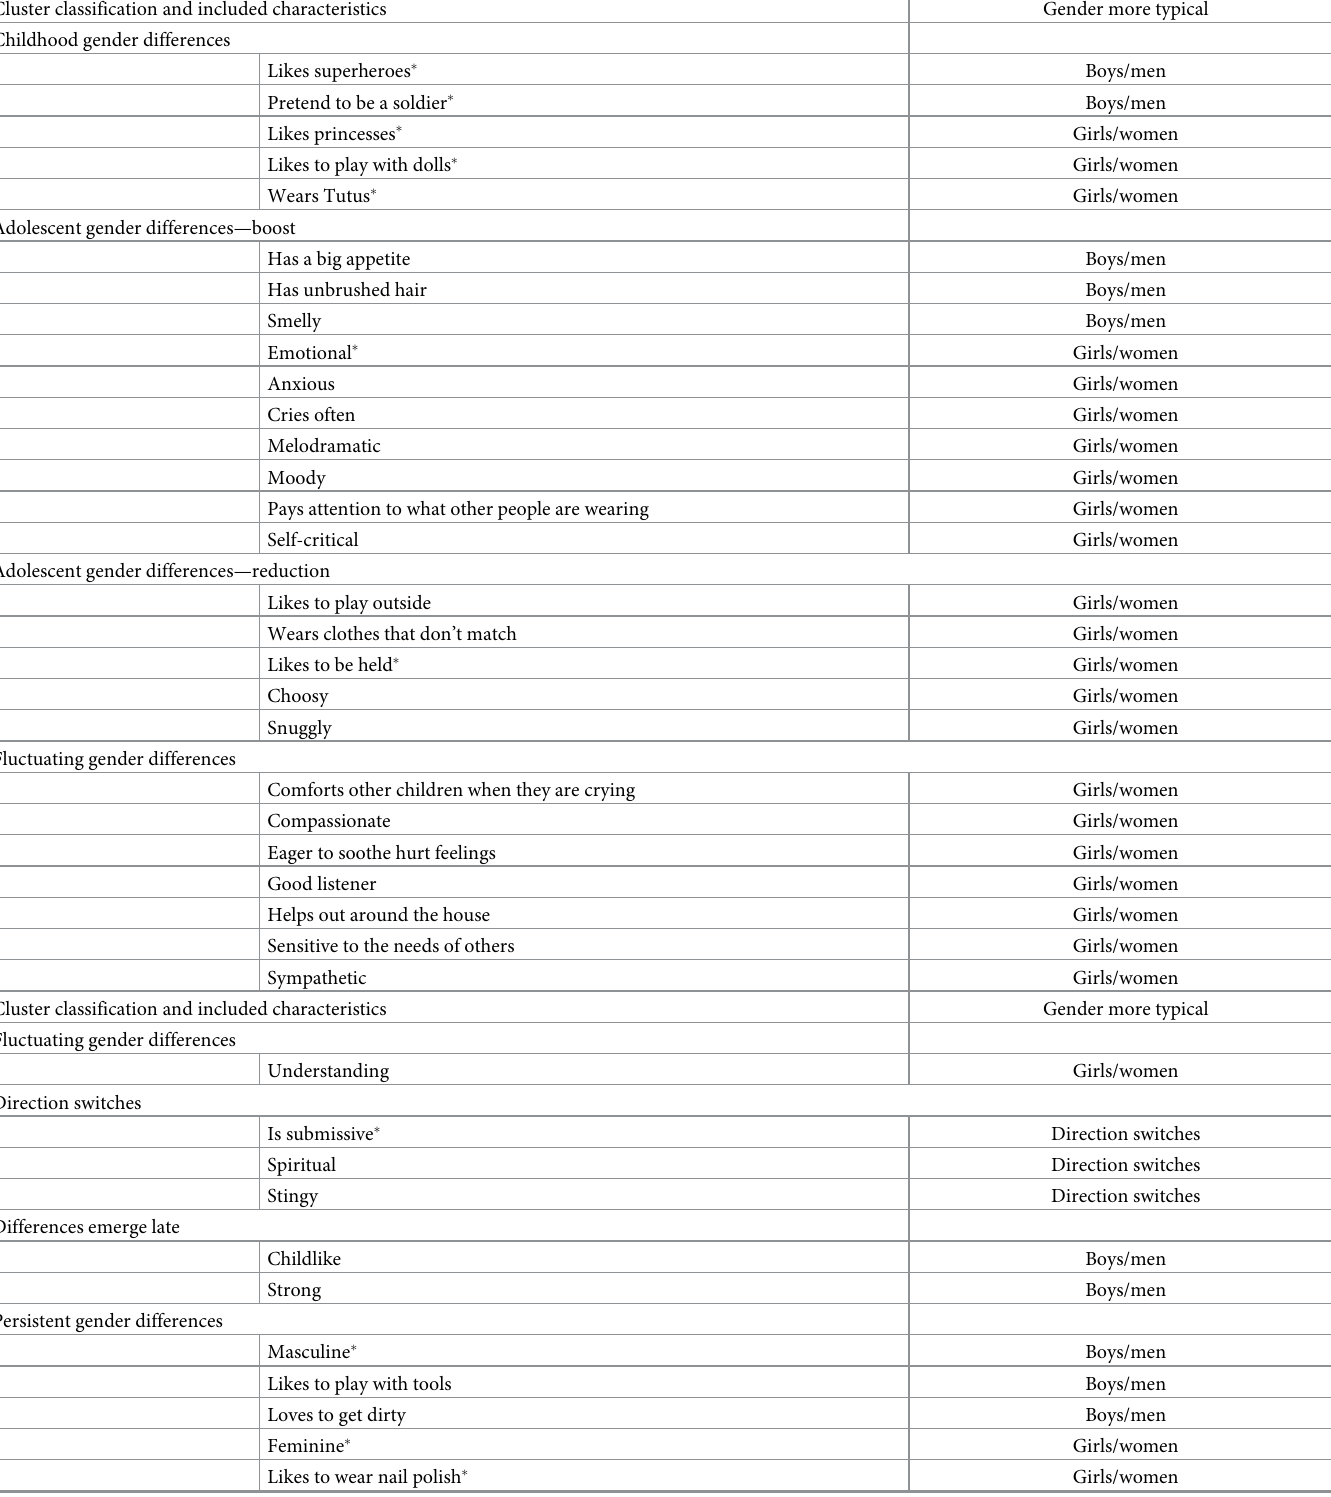
Table 6. Characteristics for which gender differences in ratings of typicality interacted with age. Cluster classification and included